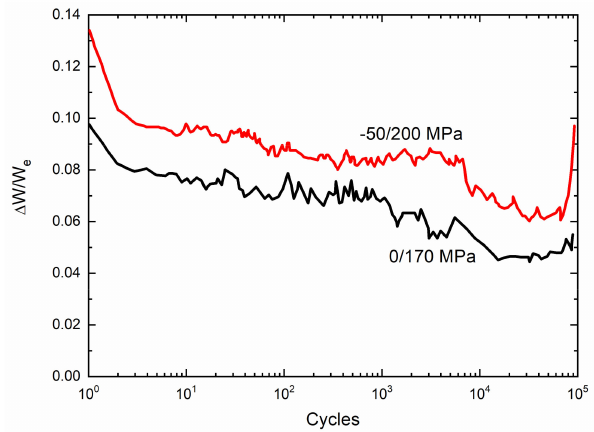
Figure 6. Experimental internal friction parameter ( ∆ W / W e ) versus cycle number curves of 2.5D woven